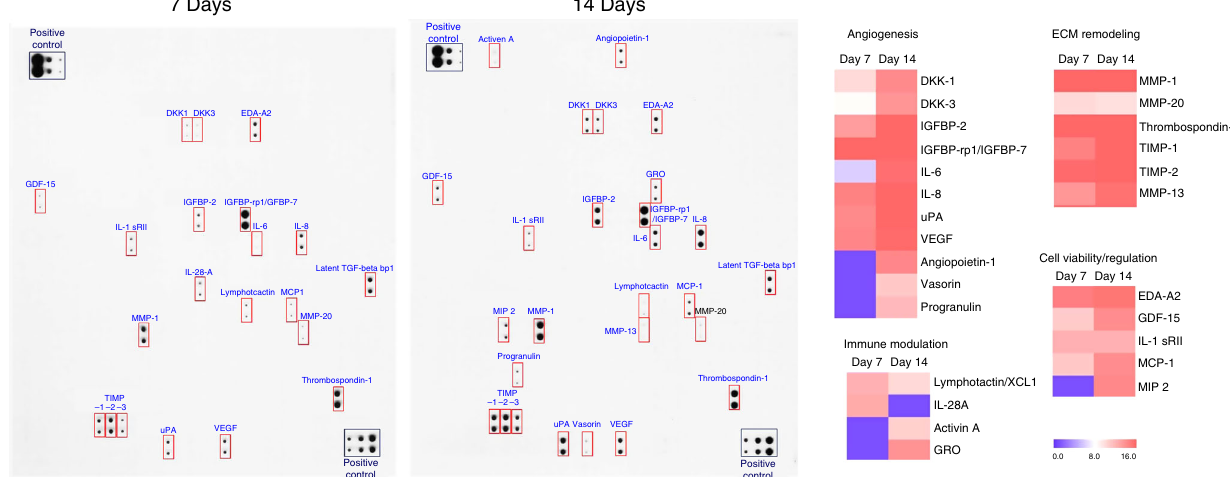
Fig. 7 Characterization of conditioned media harvested from hMSC cultures by antibody arrays. Multiple array membrane incubated with hMSC-CM collected at day 7 and day 14 reveal the presence of several paracrine factors. hMSC-CM conditioned media harvested from hMSC cultures